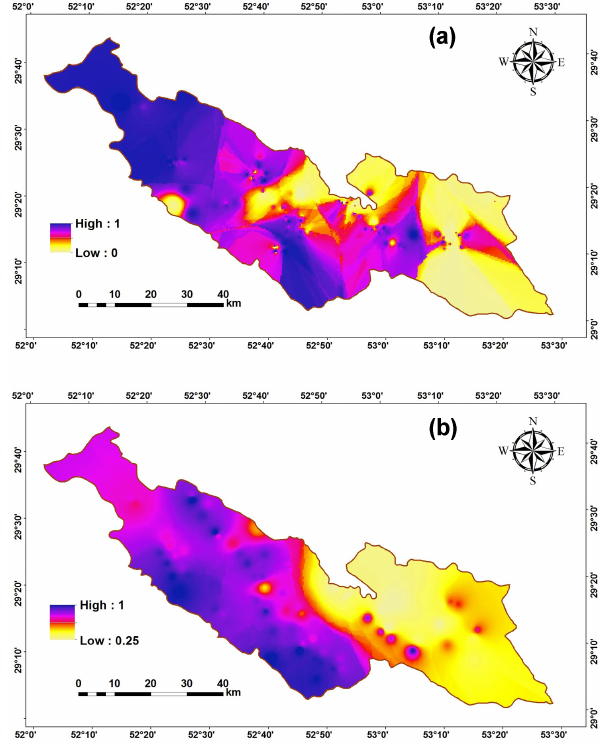
Figure 6. Fuzzy maps of the study area for (a) soil and (b) water